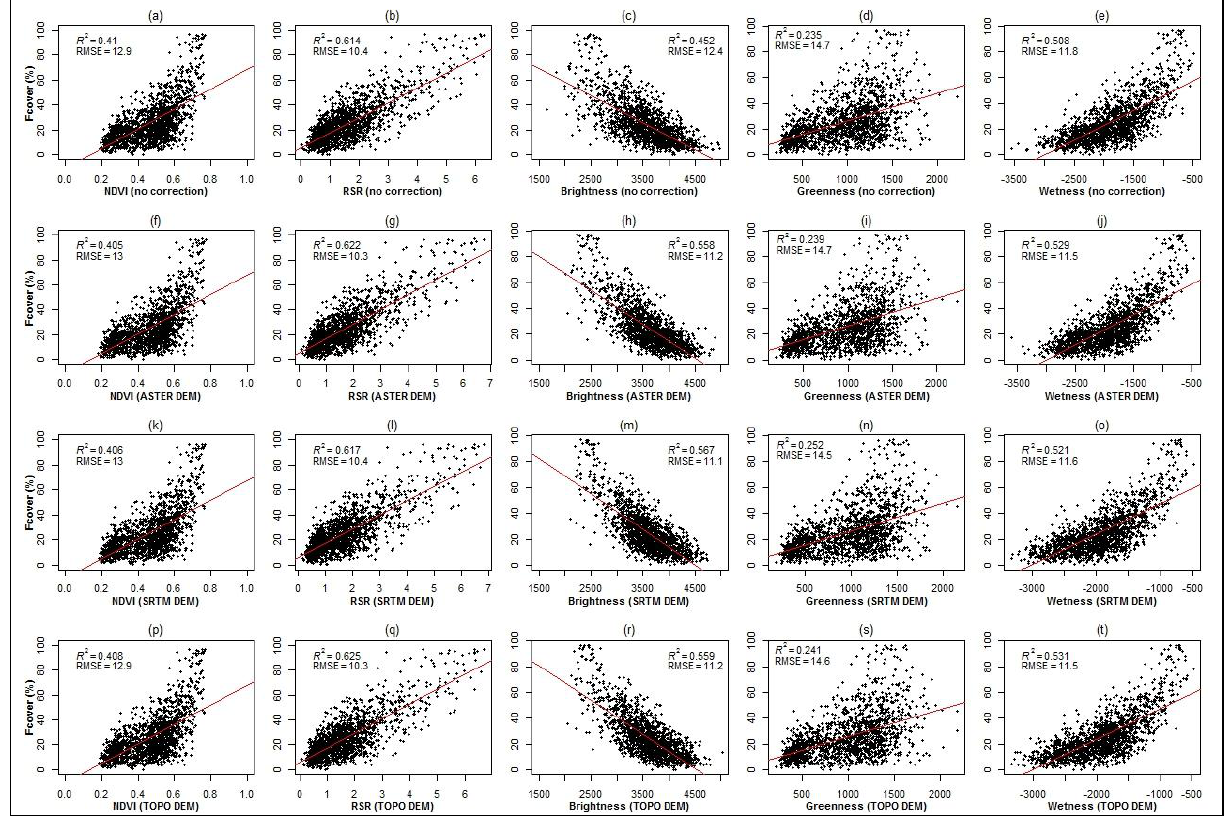
Figure 4. Simple linear regression between Fcover and NDVI, RSR and TC indices before topographic correction (first row) and after topographic correction using ASTER DEM (second row), SRTM DEM (third row) and TOPO DEM (fourth row). The image was taken at 29.9.2013 with a solar elevation angle of 64.08 °